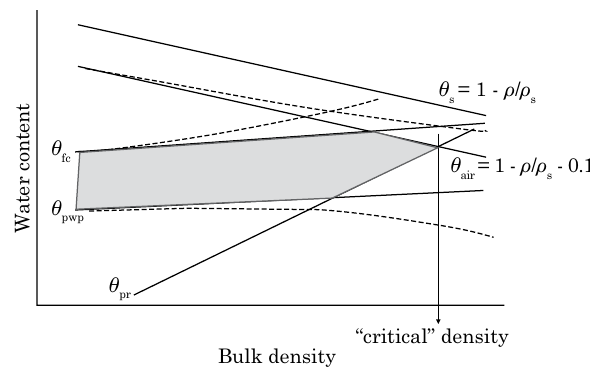
Figure 6. Representation of R LL limiting water contents versus bulk density. Solid lines represent the limiting water contents of R LL estimated based on fixed parameters; dotted lines show the expected behavior of the limiting water contents based on physical knowledge. The gray colored area represents the R LL integral over the range of represented densities. θ pwp θ fc , θ air , θ rp : water water contents corresponding to permanent wilting, field capacity, limiting air-filled porosity and limiting penetration resistance, ρ: bulk density, ρ s : particle